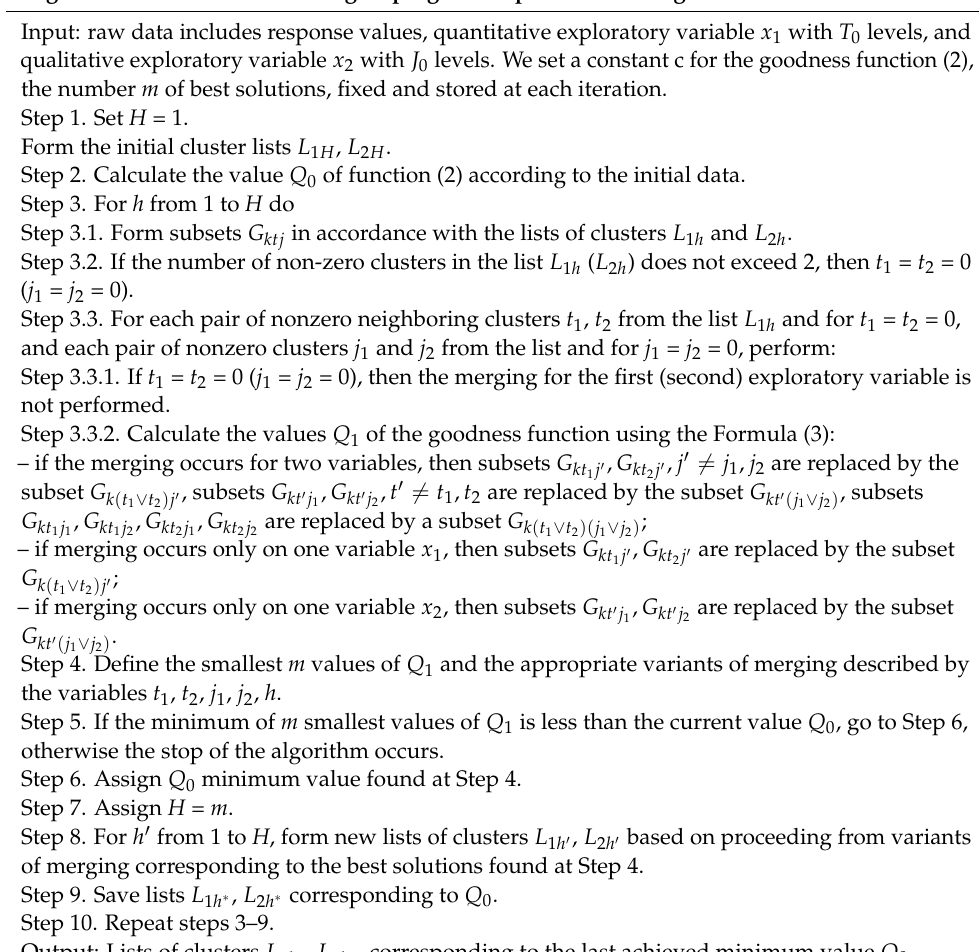
Algorithm 1 Discretization and grouping with a partial screening of the best